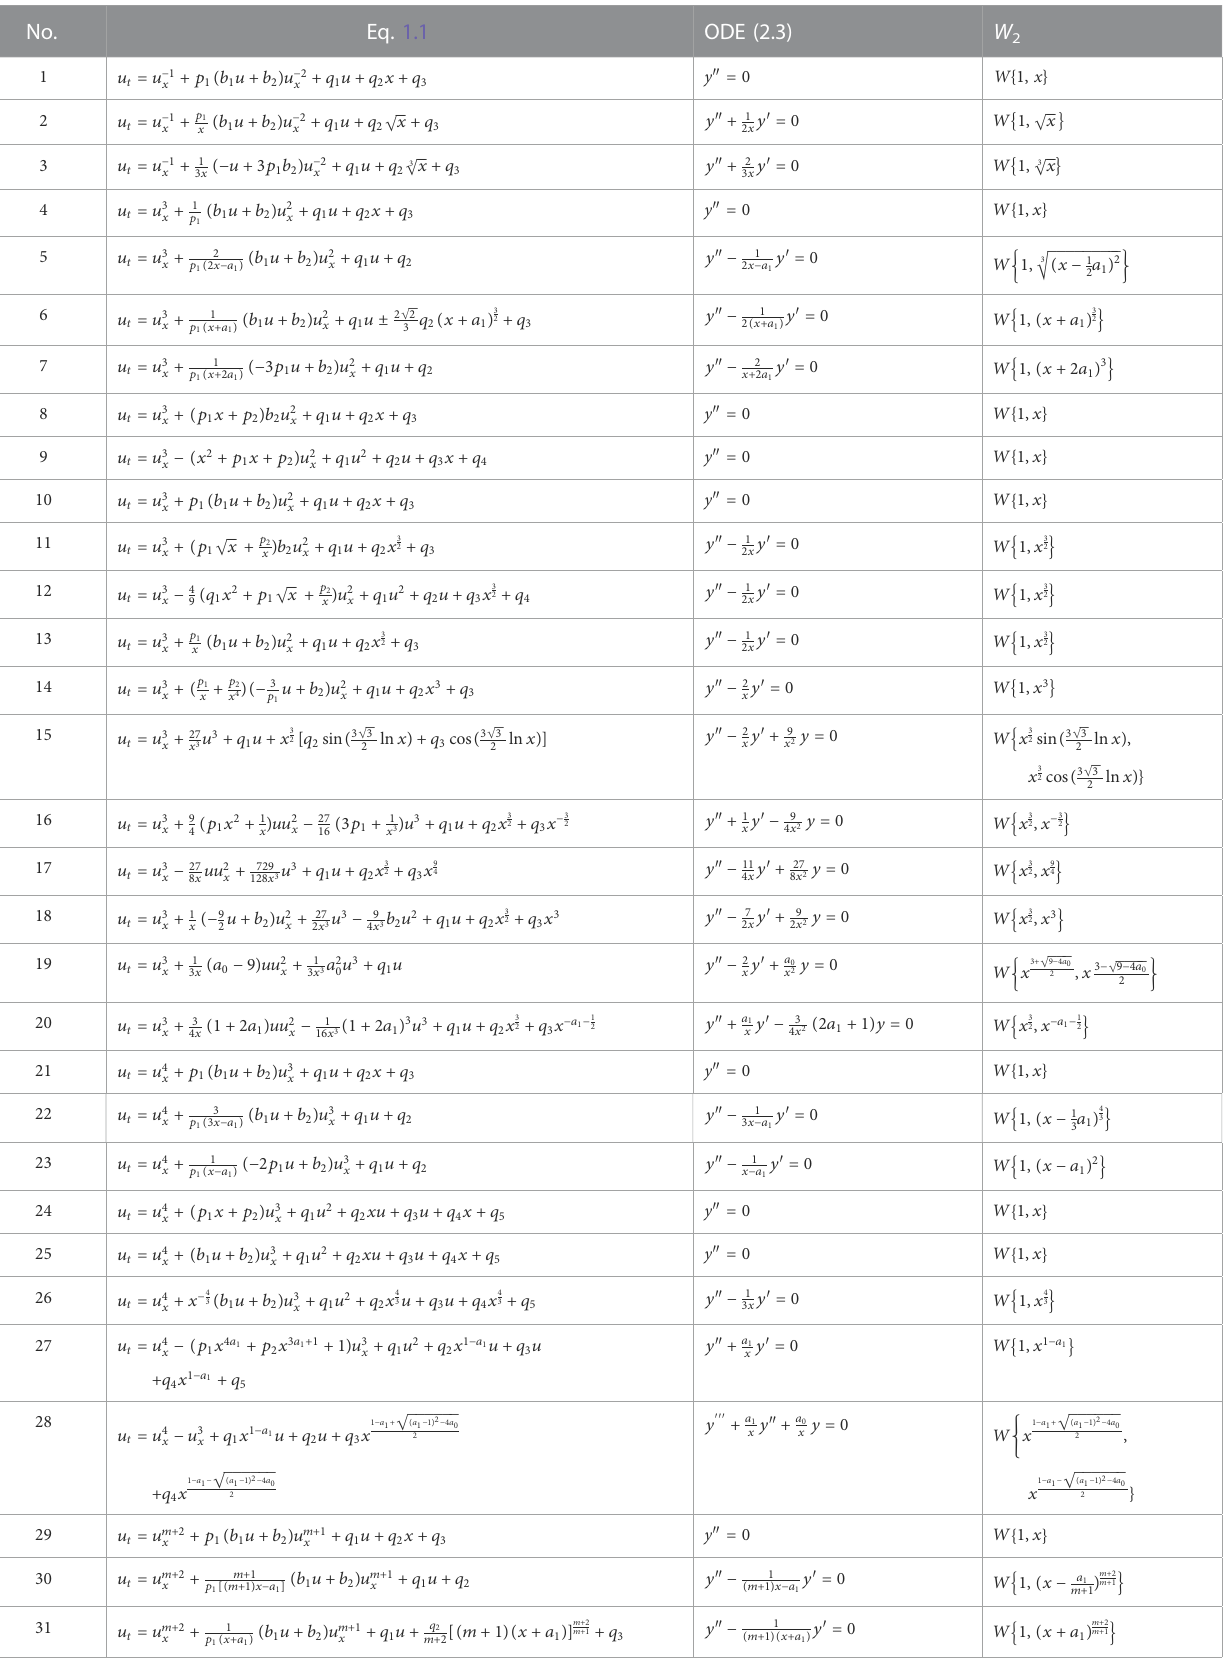
TABLE 1 Classi fi cations of W 2 governed by linear ODEs (2.3) of Eq. 1.1. No. Eq. 1.1 ODE (2.3) W